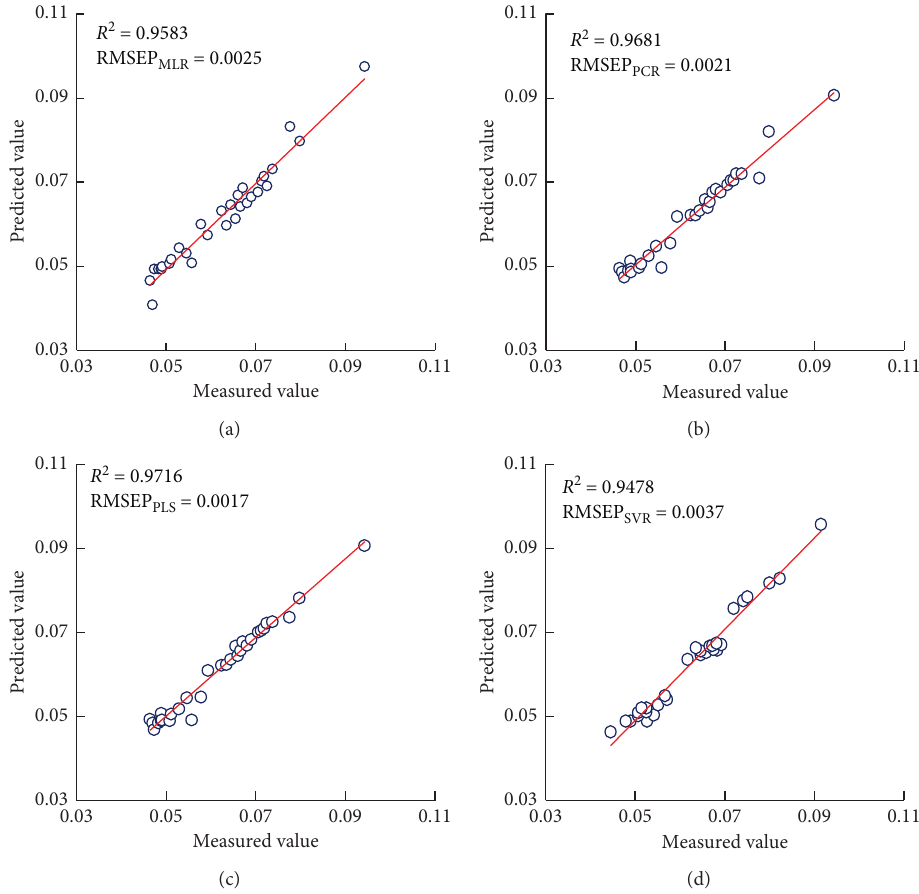
Figure 5: Prediction results of moisture content in walnut